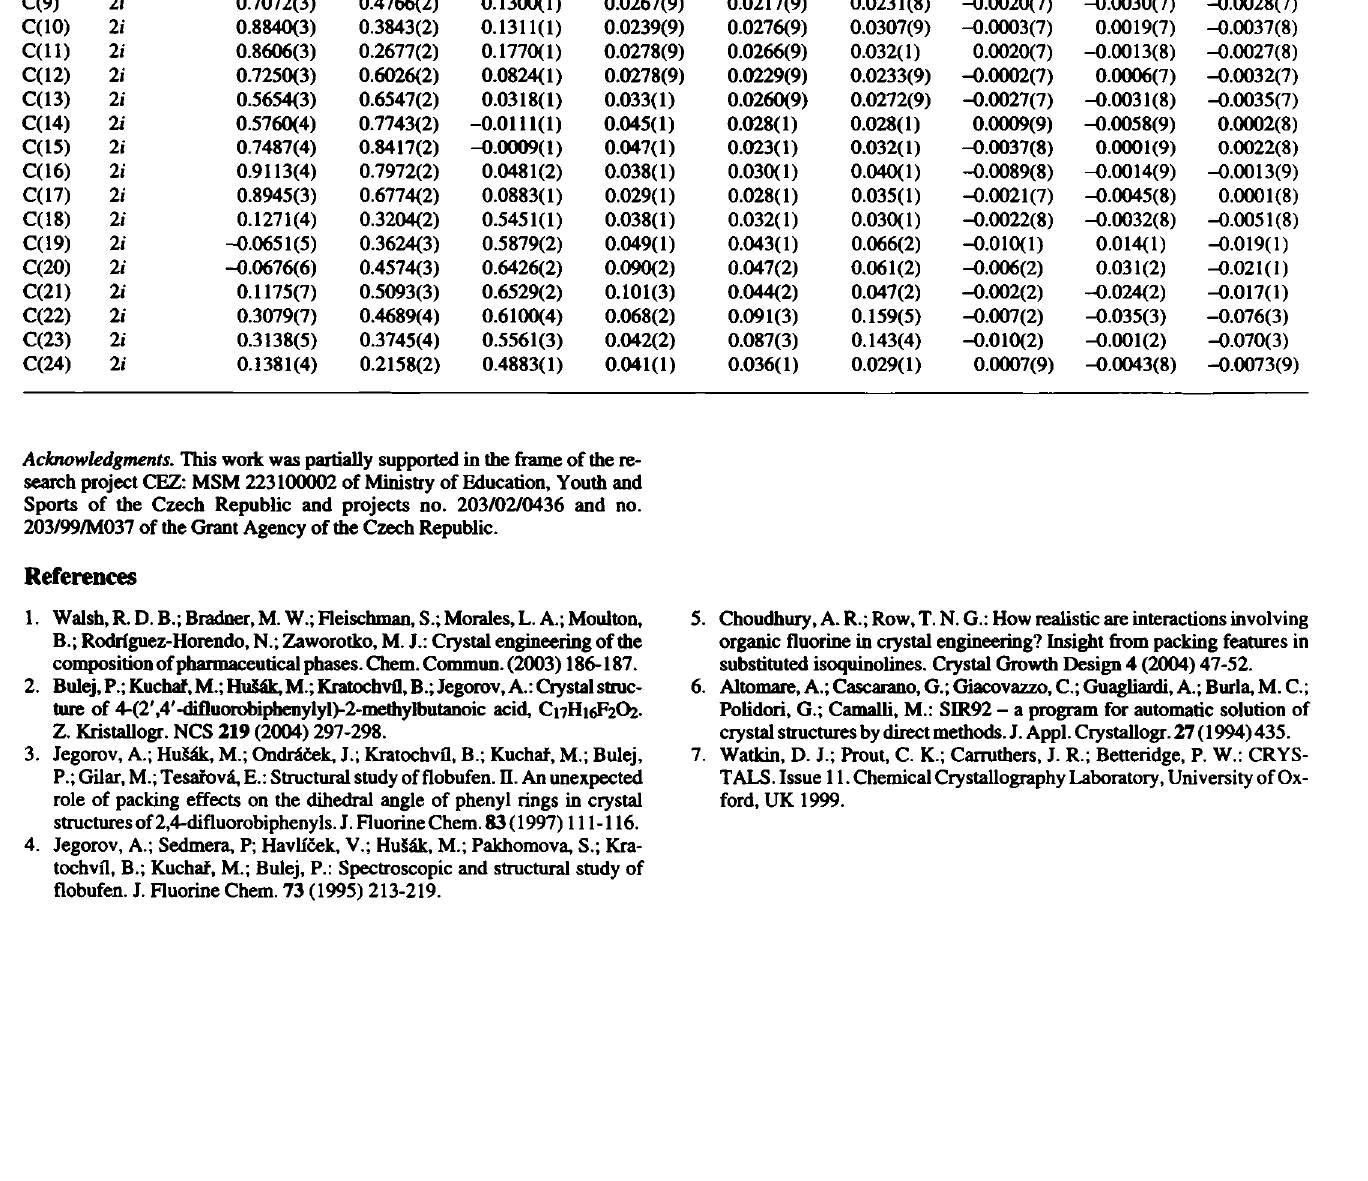
Table 3. Atomic coordinates and displacement parameters (in À 2